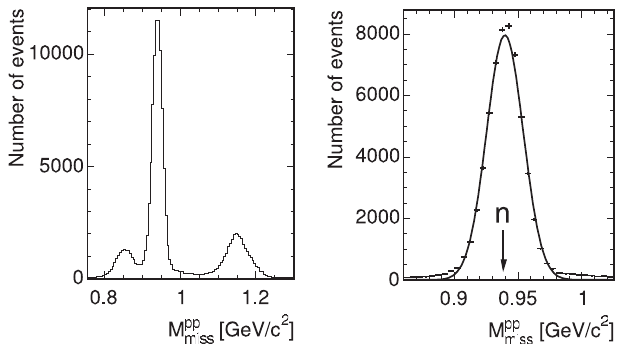
10. Missing mass distribution of all observed proton pairs (left). The distribution near the neutron mass for those pairs selected by the TOF is shown on the right. In this case there is essentially no background and a Gaussian fit to the missing mass agrees with that of the neutron to within 1%. Events falling within (cid:8) 2 : 5 (cid:6) of the center were retained in the analysis.